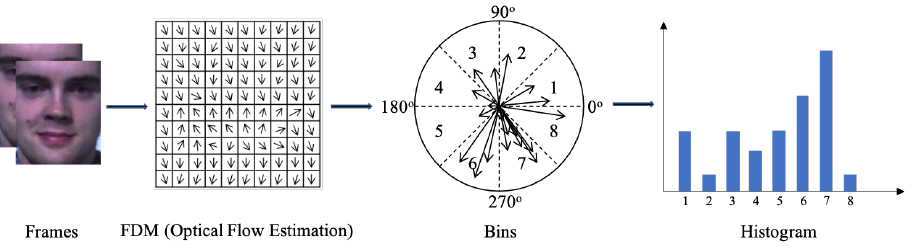
Figure 7. One-dimensional histogram of FDM from optical flow estimation.